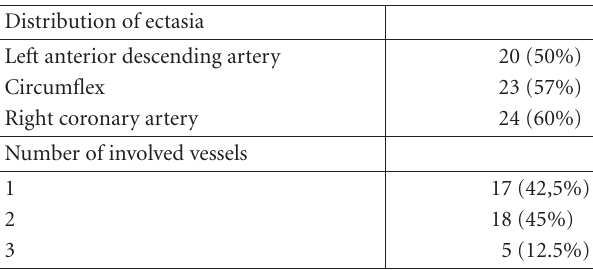
Table 2: Angiographic findings of